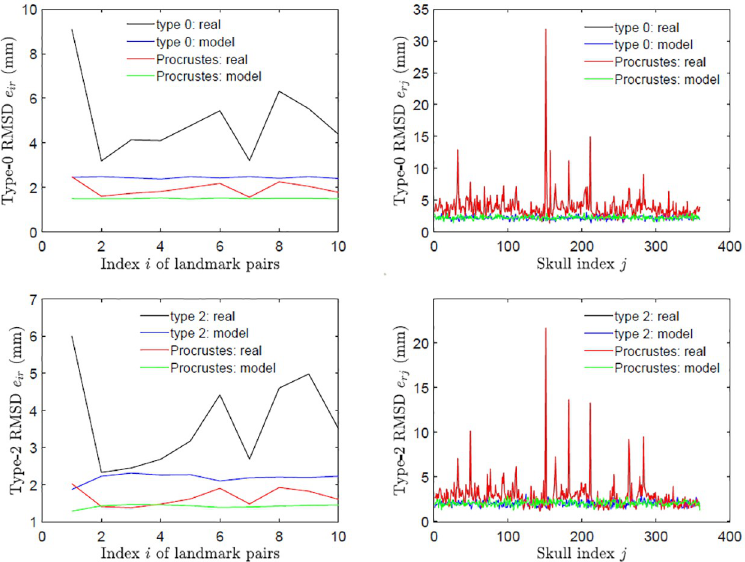
Fig 12. A comparison with the Procrustes analysis. The plots are for the perturbed symmetric skulls (model) and original skulls (real) with respect to type 0 assessment (top) and type 2 assessment (bottom) in this work, and object symmetry (top) and matching symmetry (bottom) of Procrustes method; RMSDs of asymmetry indices of landmark pairs (left), and objects (right).